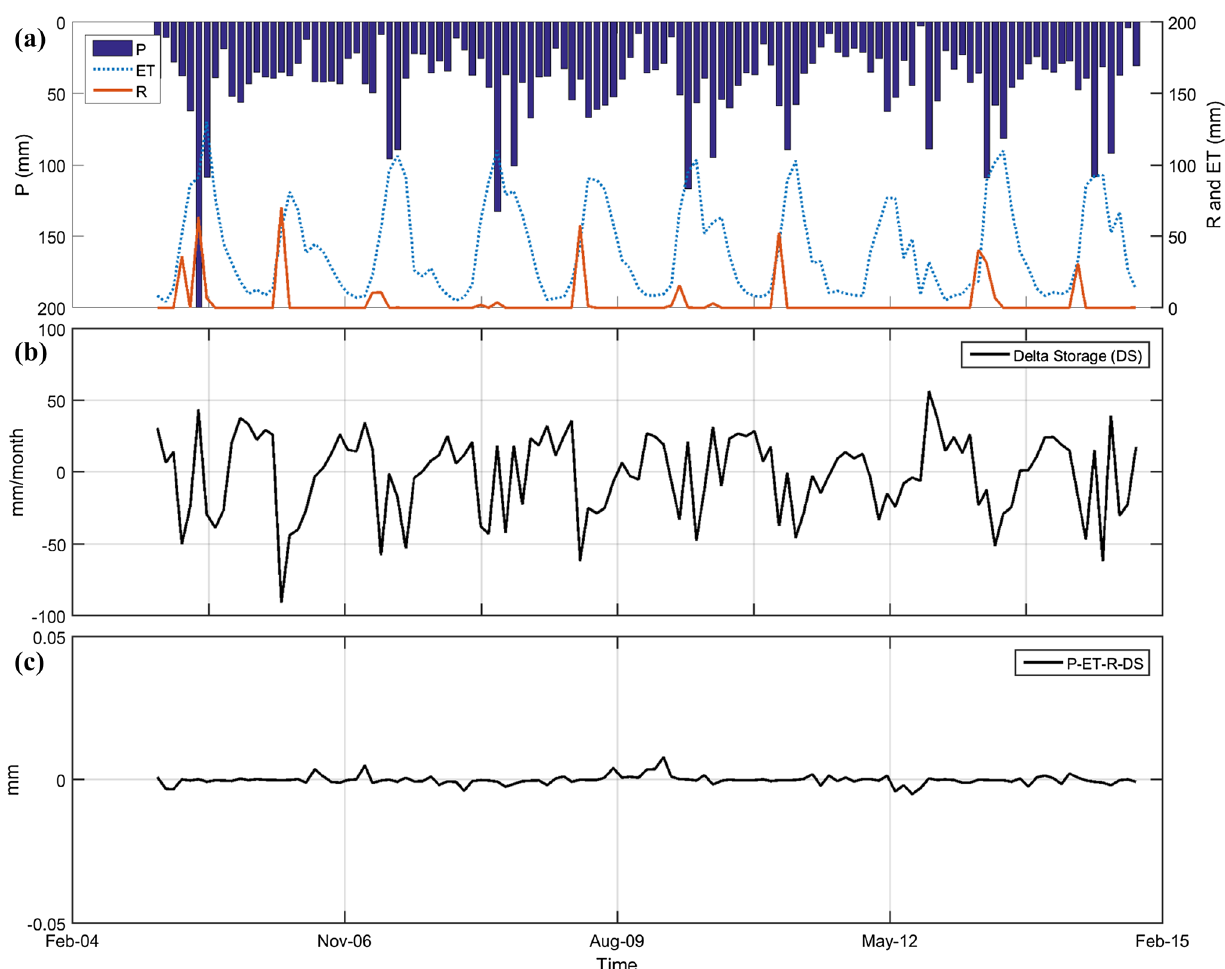
Fig. 2 Water balance for Pelly’s Lake, Manitoba, showing precip- itation (P), evapotranspiration (ET), runoff (R), and change in storage (DS). Validation of the hydrologic model for Pelly’s Lake, Manitoba, with a precipitation (P), evaporation (ET), and runoff estimates over